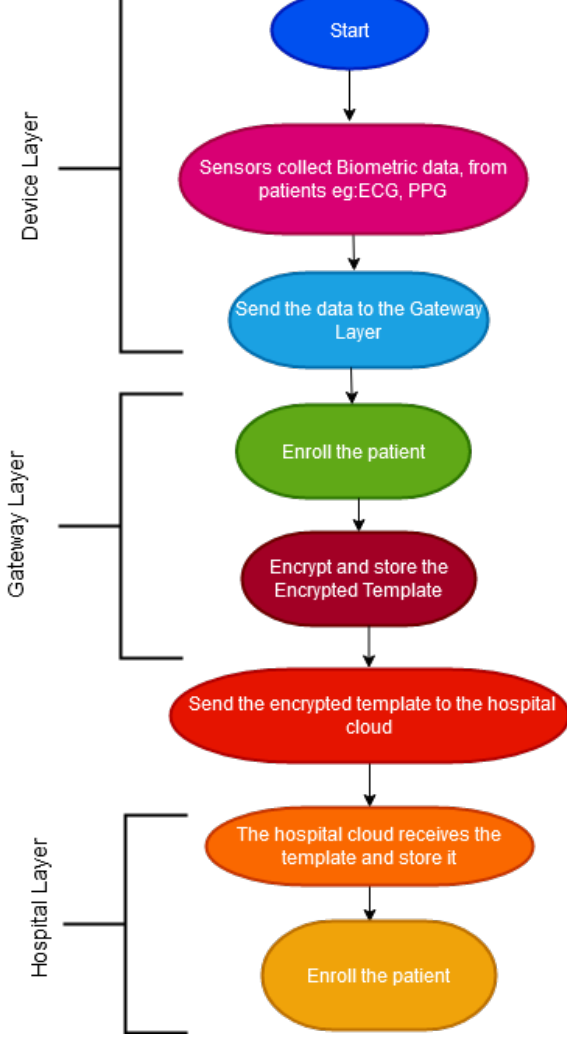
Figure 4. The enrolment